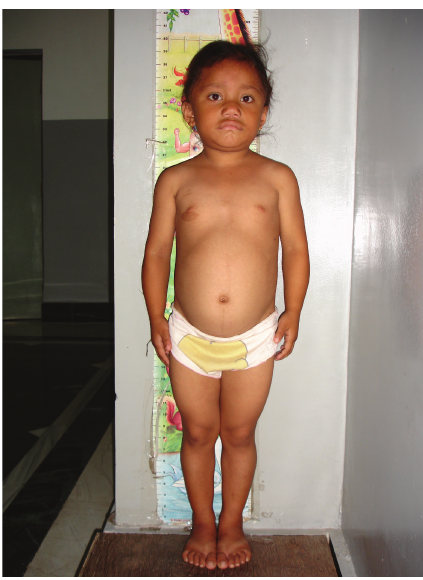
Figure 1: A 9-year-old girl with pseudomuscular hypertrophy in Kocher-Debre-Semelaigne syndrome.